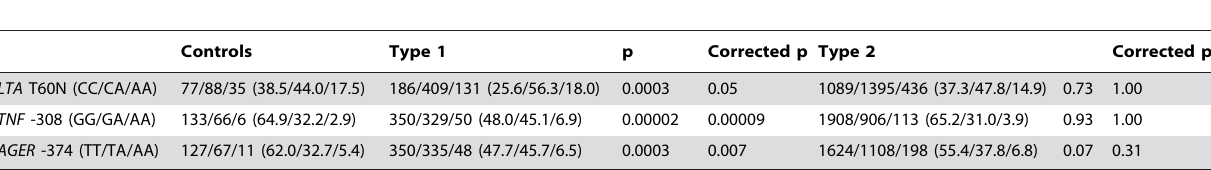
Table 2. Genotype frequencies (%) of LTA T60N (C R A), TNF -308 G R A and AGER -374 T R A polymorphism in nondiabetic controls and in type 1 and type 2 diabetic patients.